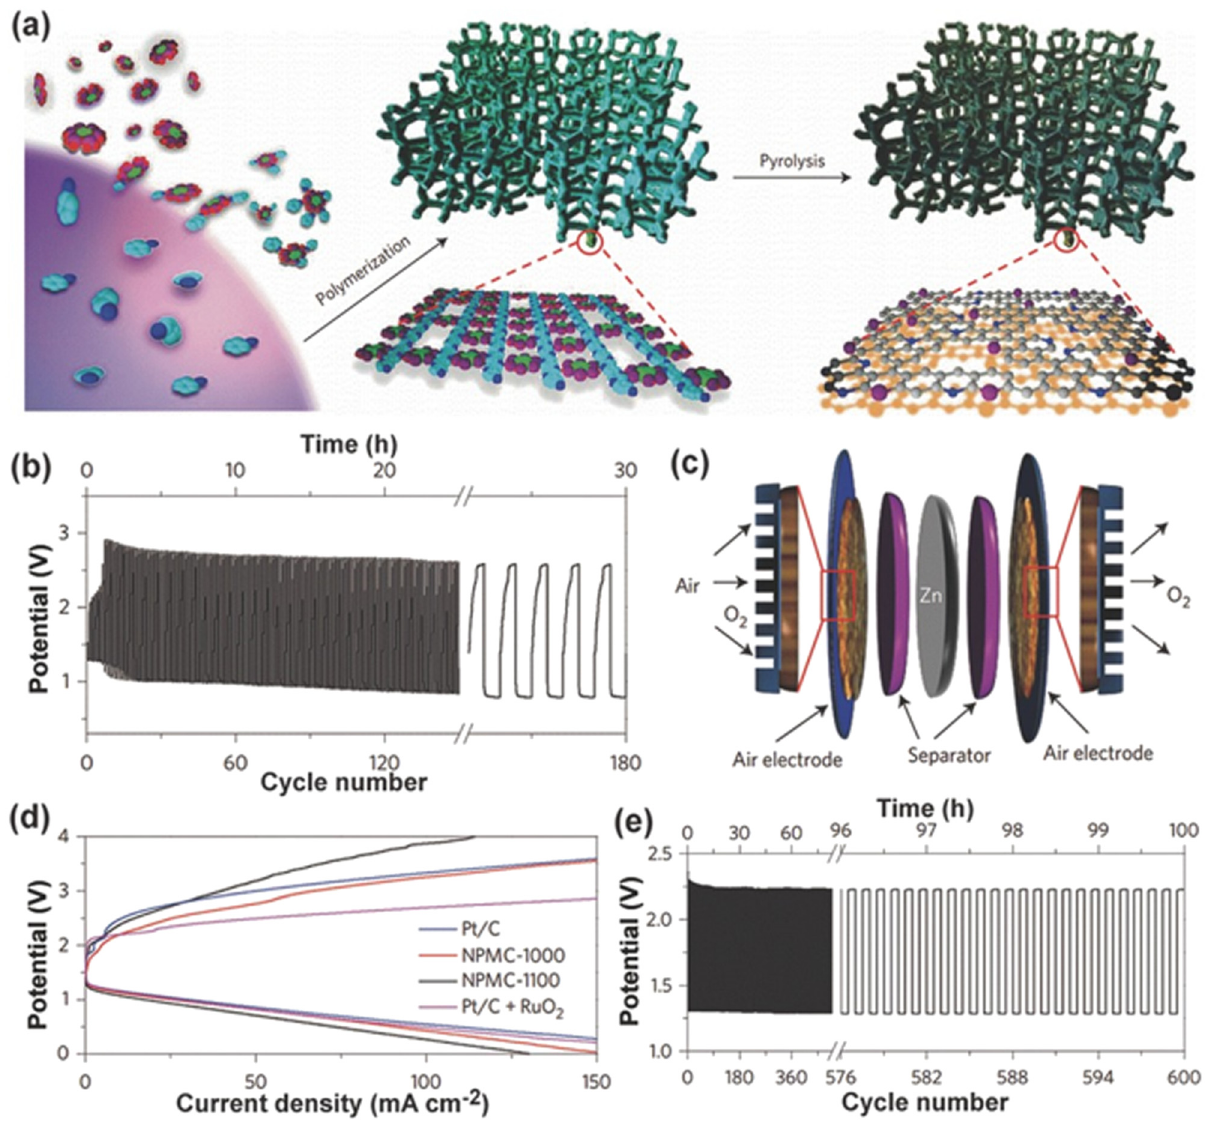
Figure 7: ( a ) Synthesis of NP – MC foams. ( b ) The discharge/charge series loops of dielectrode renewable Zn – air cells at a 2 mA cm − 2 current density depend on the NP – MC - 1000 air electrode. ( c ) Diagram of a tri - electrode Zn – air cell. The extended sections form the porous frameworks of the air electrodes, promoting gas transfer. ( d ) Charge and discharge polarization loops of trielectrode Zn – air batteries utilizing NP – MC - 1000, NP – MC - 1100, or an industrial Pt/C electrocatalyst. ( e ) Series loops ( charging/discharging ) utilizing NP – MC - 1000 for the air electrodes; whereas that catalyst was used 0.5 mg cm − 2 for ORR as well as 1.5 mg cm − 2 for OER, and current density was 2 mA cm − 2 . Redrawn from [ 119 ] , copyright 2015, Nature Publishing